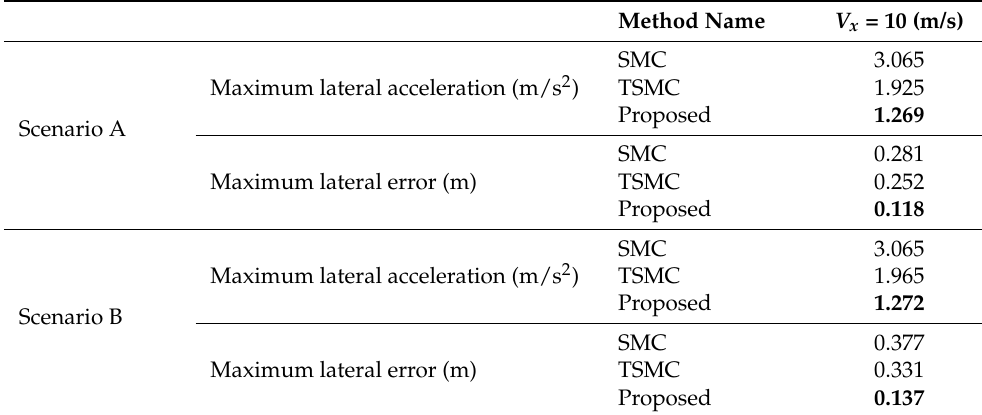
Table 2. Experimental results of the